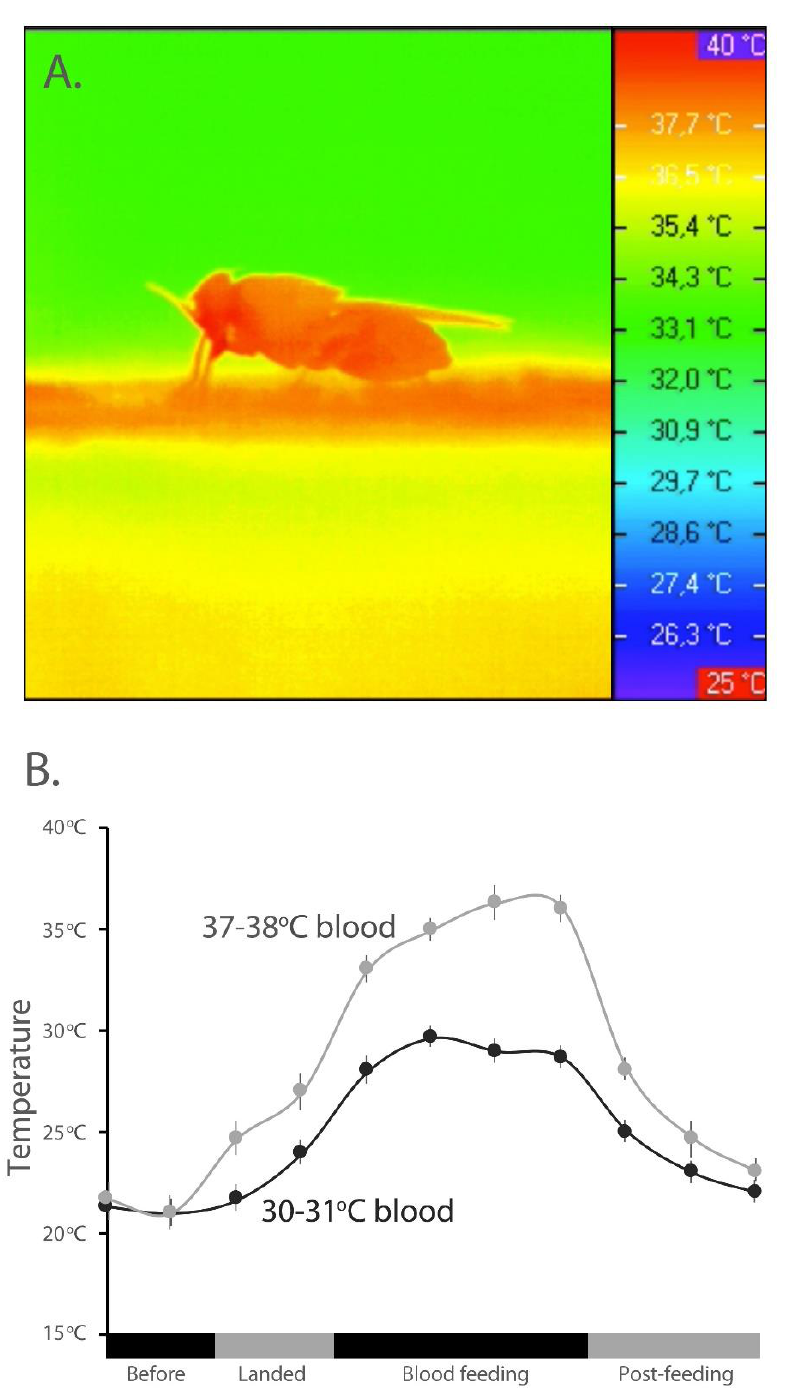
Figure 1. Thermal changes in tsetse flies during the consumption of blood. ( A ). Thermal image of tsetse fly when feeding on warm blood. ( B ). Thermal changes in tsetse fly abdomen when consuming warm and cool blood with the use of a thermocouple. There is a significant reduction in temperature from when the fly landed on the host until after the completion of feeding.